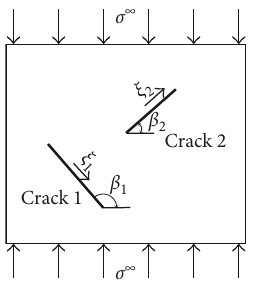
Figure 1: An infinite plate containing two cracks under uniaxial